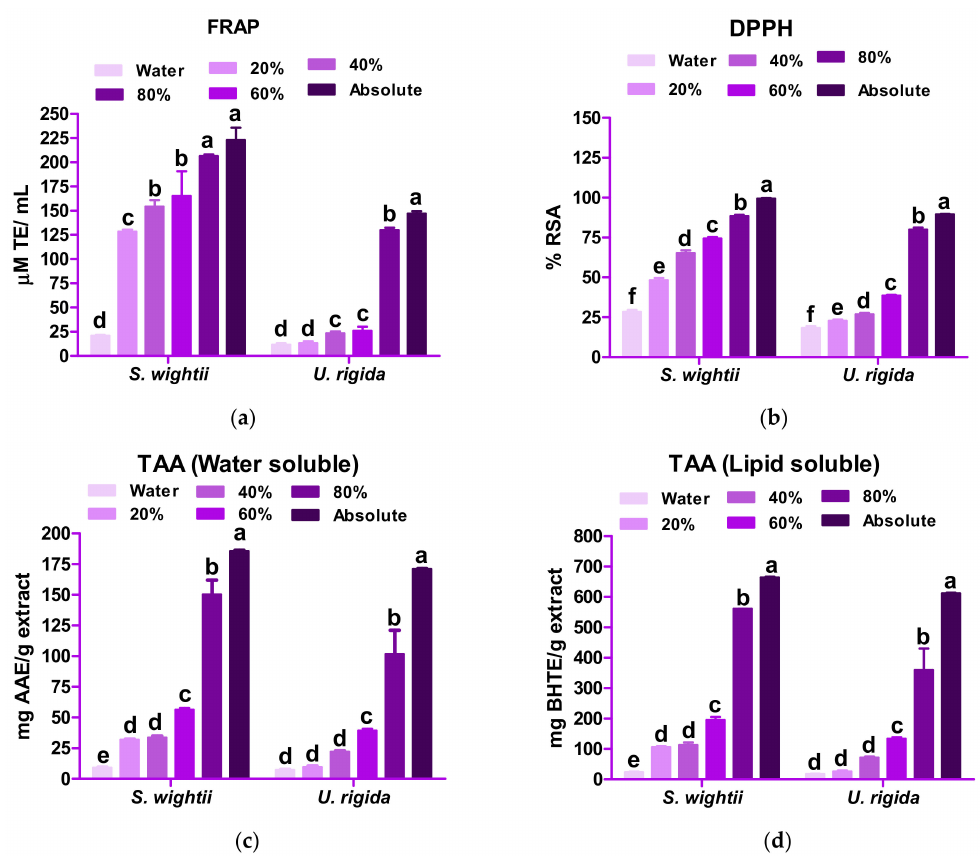
Figure 3. Ferric-reducing antioxidant power (FRAP) ( a ), percentage of radical scavenging activ- ity (DPPH) ( b ), and total antioxidant activity (water soluble ( c ) and lipid soluble ( d )) of S. wightii and U. rigida in different concentrations of methanol. Data are expressed as mean ± SD (n = 3). Mean values bearing different superscript letters (a,b . . . ) differ significantly at p < 0.05 in a Duncan’s multiple comparison post hoc test. FRAP = ferric-reducing antioxidant power; DPPH = 2,2-diphenyl- 1-picrylhydrazyl; TAA = total antioxidant activity; TE = Trolox equivalent; RSA = radical scavenging activity; AAE = ascorbic acid equivalent; BHTE = butylated hydroxy toluene